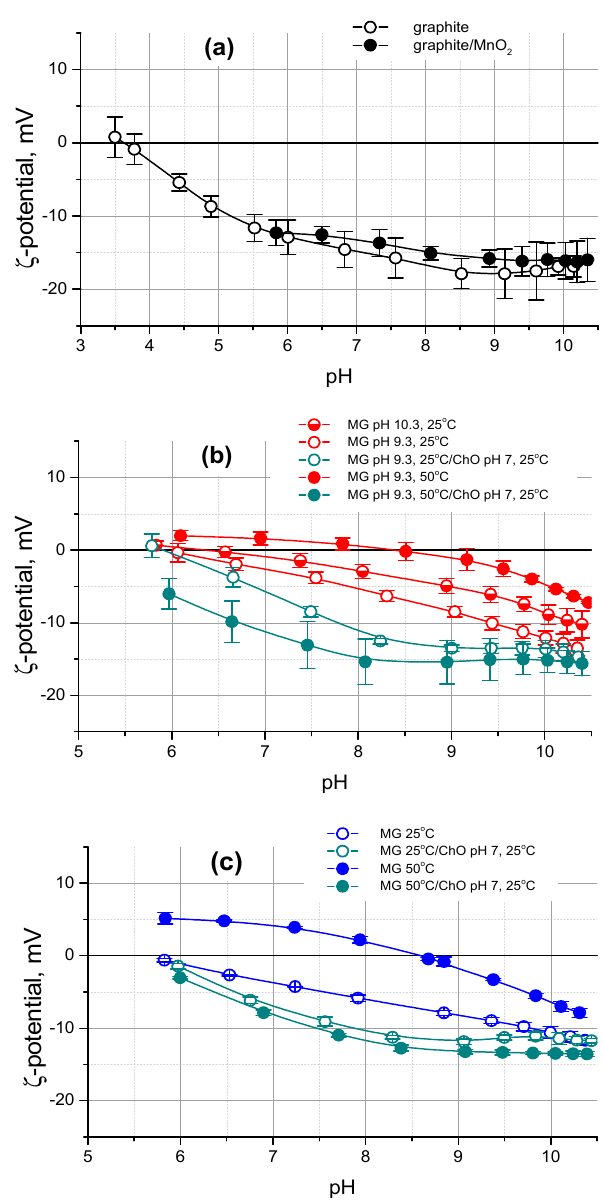
Figure 2. ( a ) ζ -potential as a function of the pH for the bare graphite surface and the graphite surface modified with MnO 2 ; ( b ) ζ -potential as a function of the pH for the film of the P(NIPAM- co -APMA) microgel adsorbed at different pH-values and temperatures onto graphite surface premodified with MnO 2 , and further interacted with choline oxidase (ChO) at pH 7 and room temperature. ( c ) ζ -potential as a function of the pH for the film of the P(NIPAM- co -DMAPMA) microgel, where P(NIPAM- co -DMAPMA) stands for poly( N -isopropylacrylamide- co - N -[3-(dimethylamino)propyl] methacrylamide), adsorbed at pH 9.3 and different temperatures onto graphite surface premodified with MnO 2 and further interacted with ChO at pH 7 and room temperature. The support is a poly(vinyl chloride) (PVC) film. MG is the abbreviation used for a microgel.